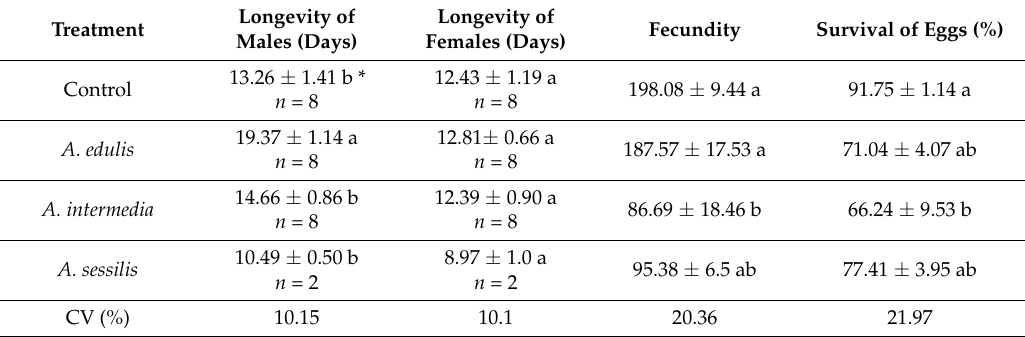
Table 2. Longevity of adult males and females, fecundity and egg survival (%) of Plutella xylostella L. treated with of Alibertia edulis , Alibertia intermedia , and Alibertia sessilis aqueous extracts. Longevity of Treatment Males